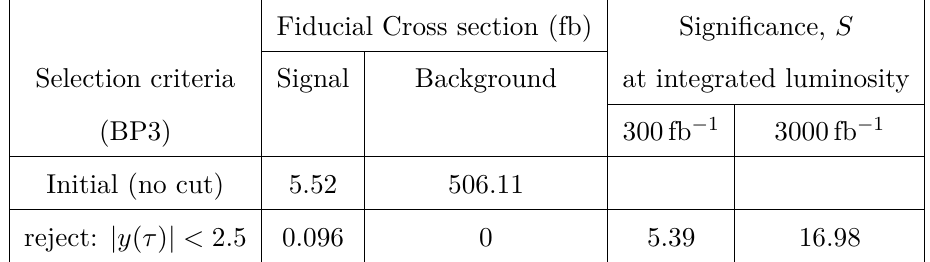
Table 13 . Fiducial cross section of the signal ( pp → H + ( pp → νντ + τ − ) corresponding to BP3 at 14 TeV LHC, with and without the selection criteria considered, and the signal significance (eq. (4.1)) at the